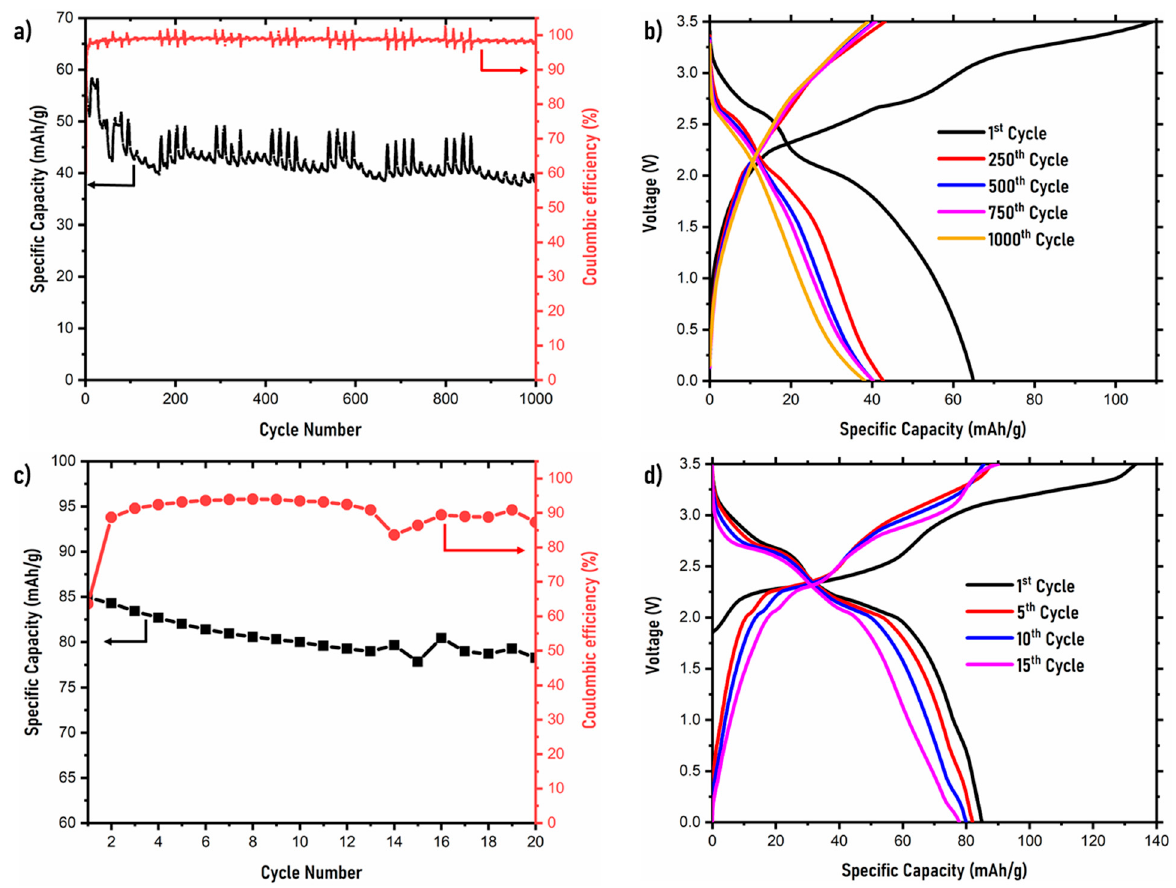
Figure 4. Cycling performance and galvanostatic charge–discharge curves of NVPF symmetric cell at ( a , b ) 1 C and ( c , d ) 0.1 C.